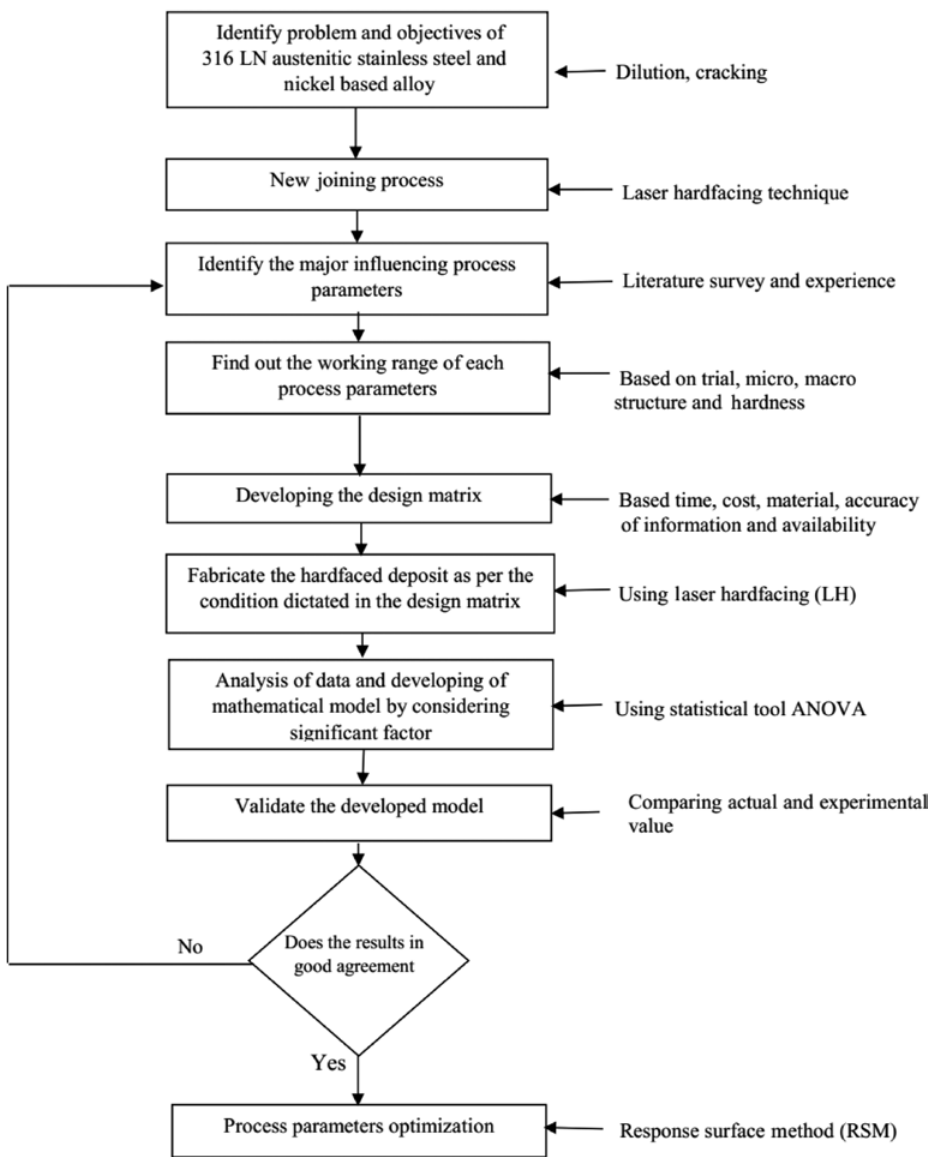
Figure 1: Flow chart for process